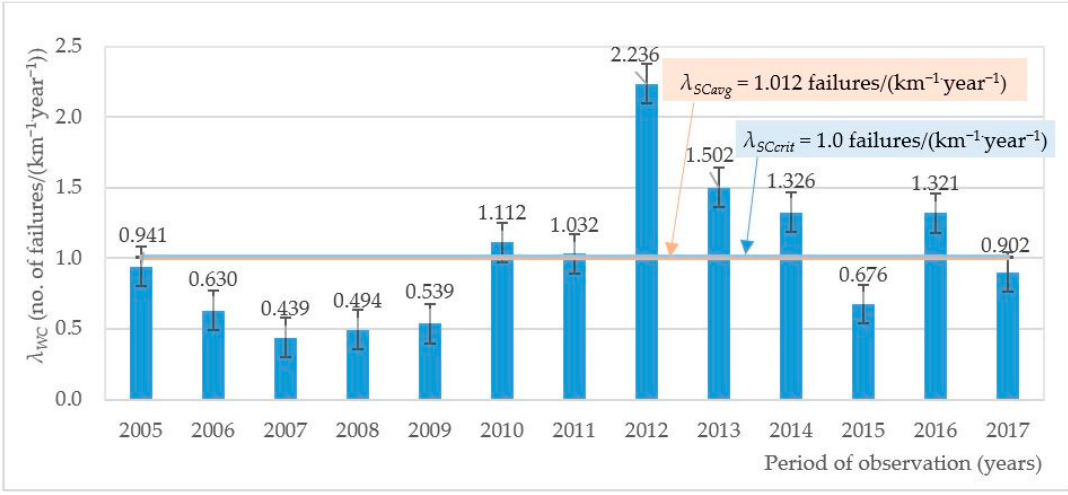
Figure 4. The failure rate for distribution pipes over the distinguished 2005–2017 period.